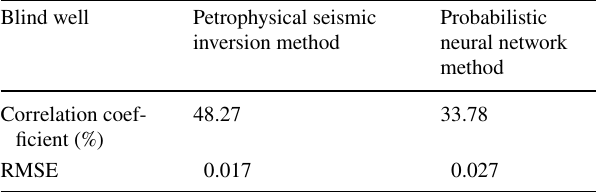
Fig. 7 Residual error between modeled and inverted acoustic impedance a cross-section of first residual error b cross section of final residual error and c average residual error for different iteration numbers using two methods of Newton–Raphson and Secant at well location Table 1 Correlation coefficient and RMSE between measured poros- ity log and predicted one using two methods: petrophysical seismic inversion and probabilistic neural network Blind